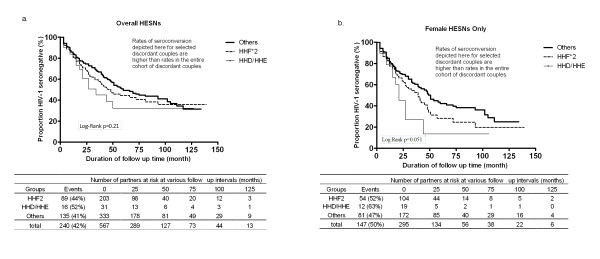
Association of two CCR2-CCR5 diplotype (HHD/HHE and HHF*2) with time to HIV-1 acquisition among initially seronegative partners of HIV-1 discordant Zambian couples. Analysis was based on 567 initially seronegative HESNs (panel a) or 295 seronegative female HESNs only (panel b). Vertical lines on each Kaplan-Meier curve represent subjects censored at the last follow up visit (before December 2006).